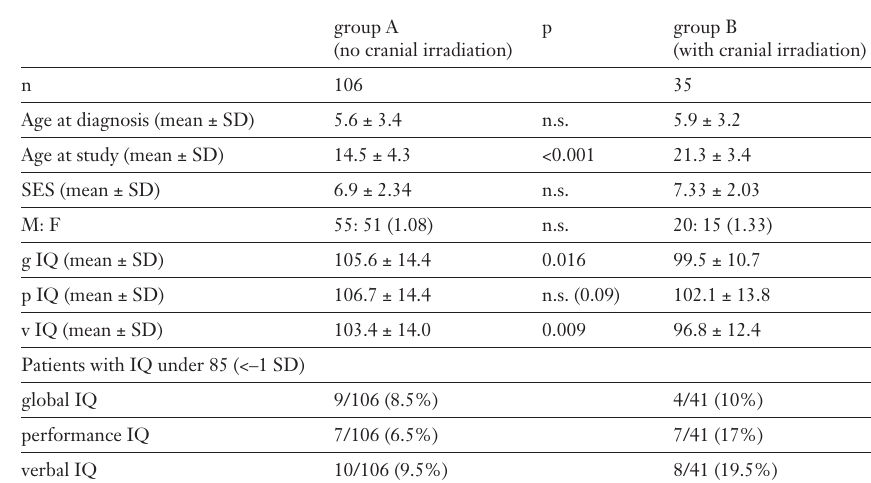
Intellectual achieve- ment according to CNS prophylaxis.